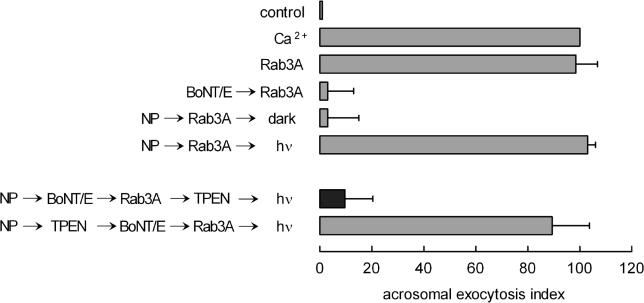
Activation with Rab3A Triggers the Disassembly of SNARE Complexes before Intra-Acrosomal Ca2+ EffluxPermeabilized spermatozoa were loaded with 10 μM NP-EGTA-AM (NP) for 15 min at 37 °C to chelate intra-acrosomal Ca2+. Then 357 nM BoNT/E was added to the system, and AE was initiated by adding 300 nM GTP-γ-S-loaded Rab3A. After 15 min at 37 °C, the toxin was inactivated with 2.5 μM TPEN, and photolysis of NP was induced by UV illumination (hν). The samples were incubated for a further 5 min to promote exocytosis (NP→BoNT/E→Rab3A→TPEN→hν, black bar). At the end of the incubation, sperm were fixed and AE was measured as described in Materials and Methods. Several controls are included (grey bars): background AE in the absence of any stimulation (control); AE stimulated by 10 μM free Ca2+ (Ca2+) or Rab3A (Rab3A); blockage of Rab3A-triggered exocytosis by BoNT/E (BoNT/E→Rab3A); inhibitory effect of NP-EGTA-AM in the dark (NP→Rab3A→dark) and the recovery upon illumination (NP→Rab3A→hν); and inactivation of the neurotoxin by TPEN (NP→TPEN→BoNT/E→Rab3A→hν). The data were normalized as described in Materials and Methods (mean ± SEM). Statistical analysis is provided in Table S4.